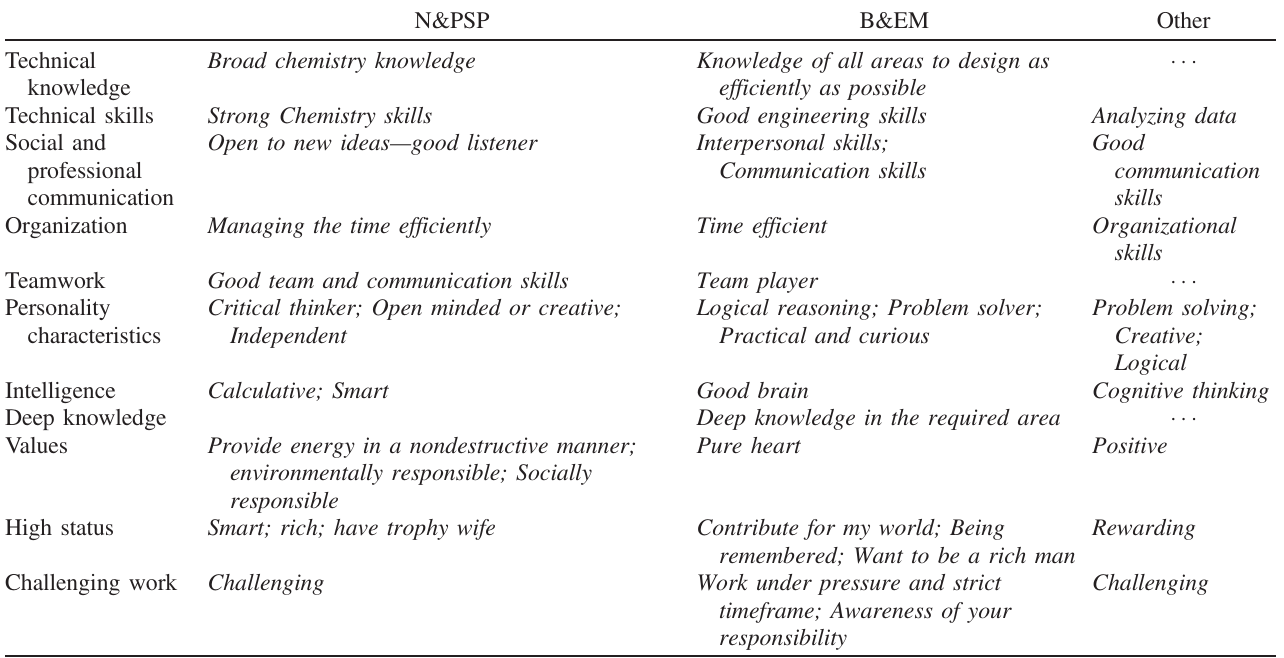
TABLE III. Example responses for each category of perceived characteristics of professional by occupational grouping. Note that N & PSP ¼ Natural and physical science professionals, B & EM ¼ Building and engineering